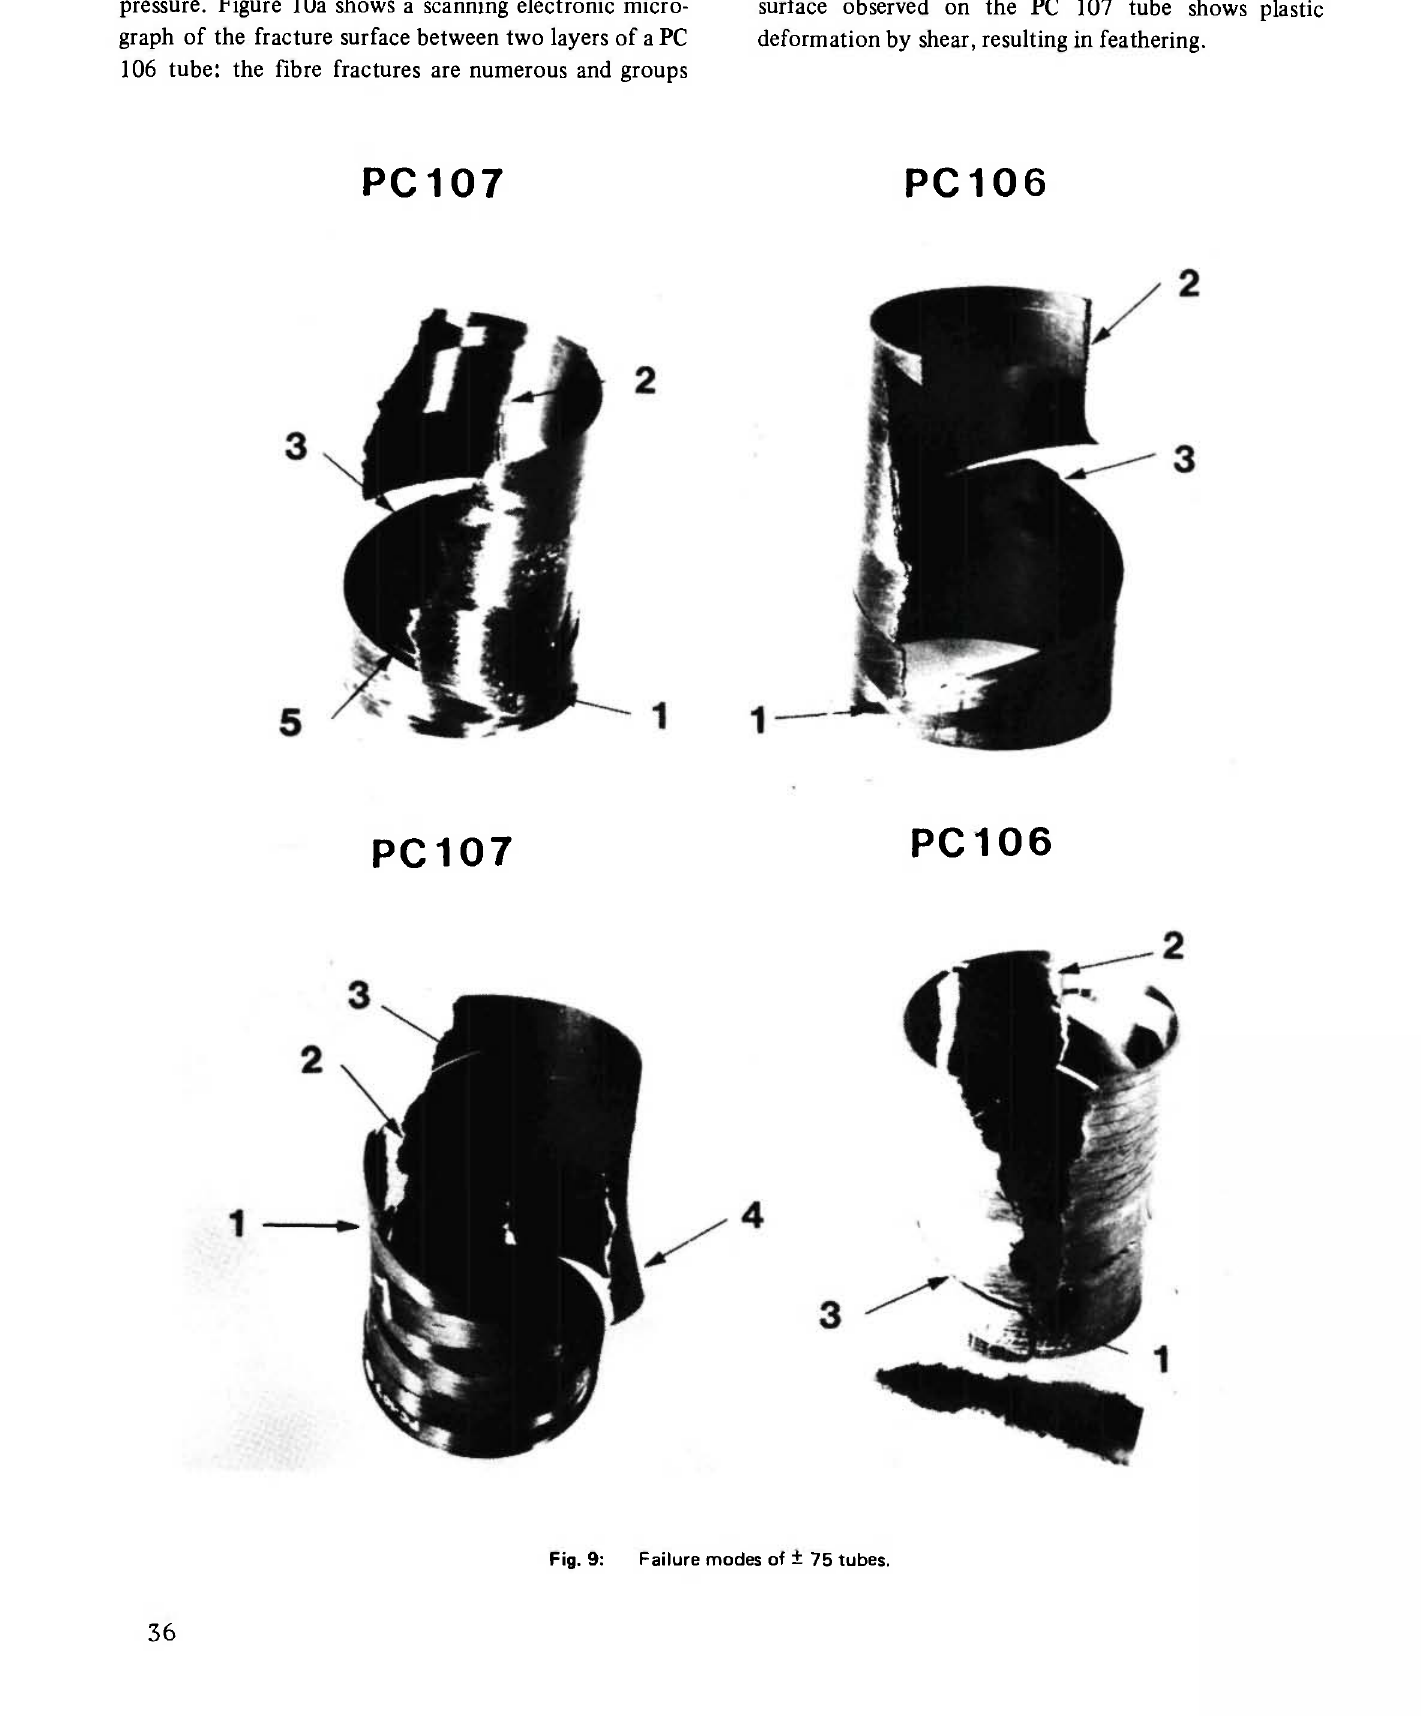
Fig. 9: Failure modes of ± 75